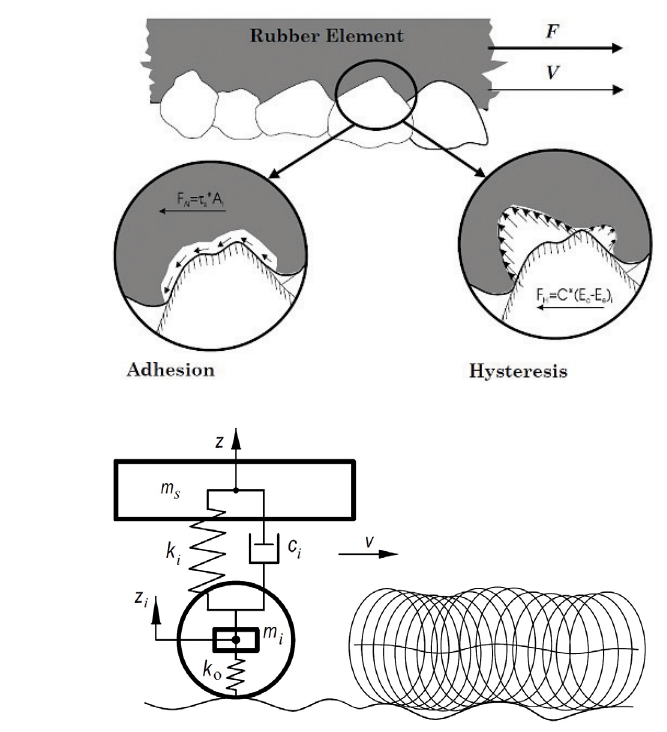
Figure 2. Vehicle – road interaction: a) adhesion and hysteresis between tire and pavement (Hall et al., 2006); b) vertical dynamics of vehicle